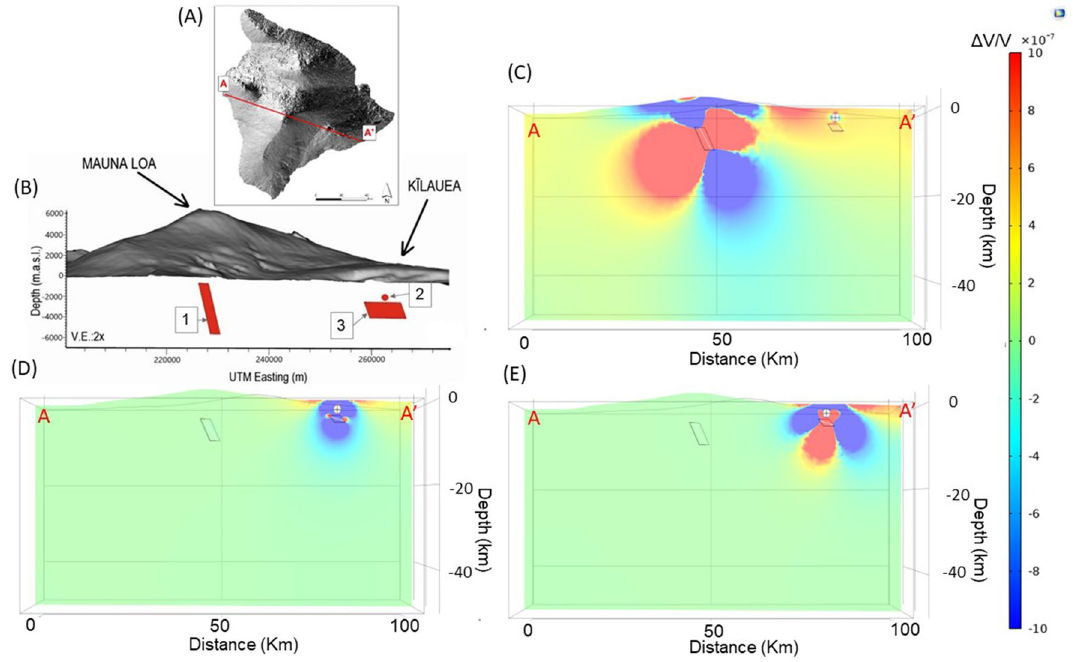
Figure 7. 3D numerical modelling of strain fields. ( A ) The Digital Elevation Model of Hawai’i Island, with the red line representing the trace (A-A ′ ), used in panels ( C – E ). ( B ) tridimensional representation of the modelled ground deformation sources of Mauna Loa and Kīlauea volcanoes. The sources are numbered according to Table S1 in the supplementary material. (1) the Mauna Loa dike-shaped source from ICA1; (2) the Kīlauea Mogi-like source from ICA1; (3) the Kīlauea sill-shaped source from ICA2. Storage areas and topography are exaggerated in size for clarity. ( C ) the volumetric strain field represented along the A-A ′ trace due to an overpressure applied to the Mauna Loa dike-like source. ( D ) volumetric strain field along the A-A ′ trace due to an overpressure applied to the Kīlauea Mogi-like source. ( E ) volumetric strain field along the A-A ′ trace due to an overpressure applied to the Kīlauea sill-like